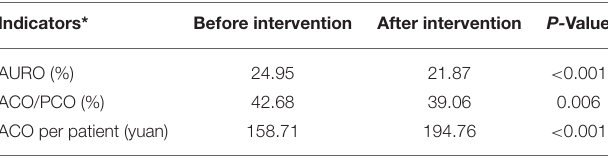
TABLE 4 | Overall changes of three indicators representing antibiotic use in outpatient.